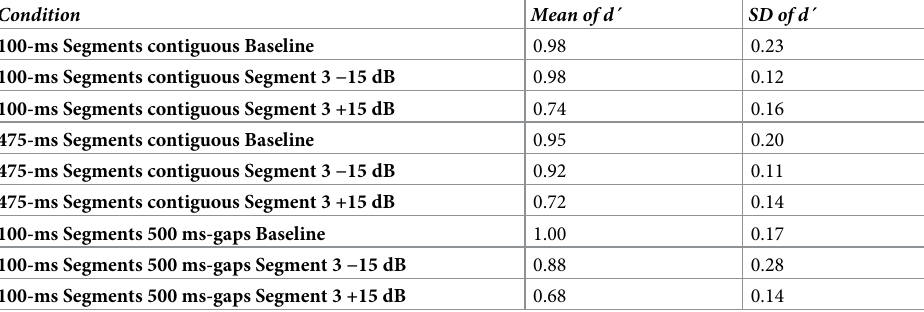
Table 5. Mean sensitivity across listeners ( d´ ) in the nine different conditions of Experiment 3. N = 9.